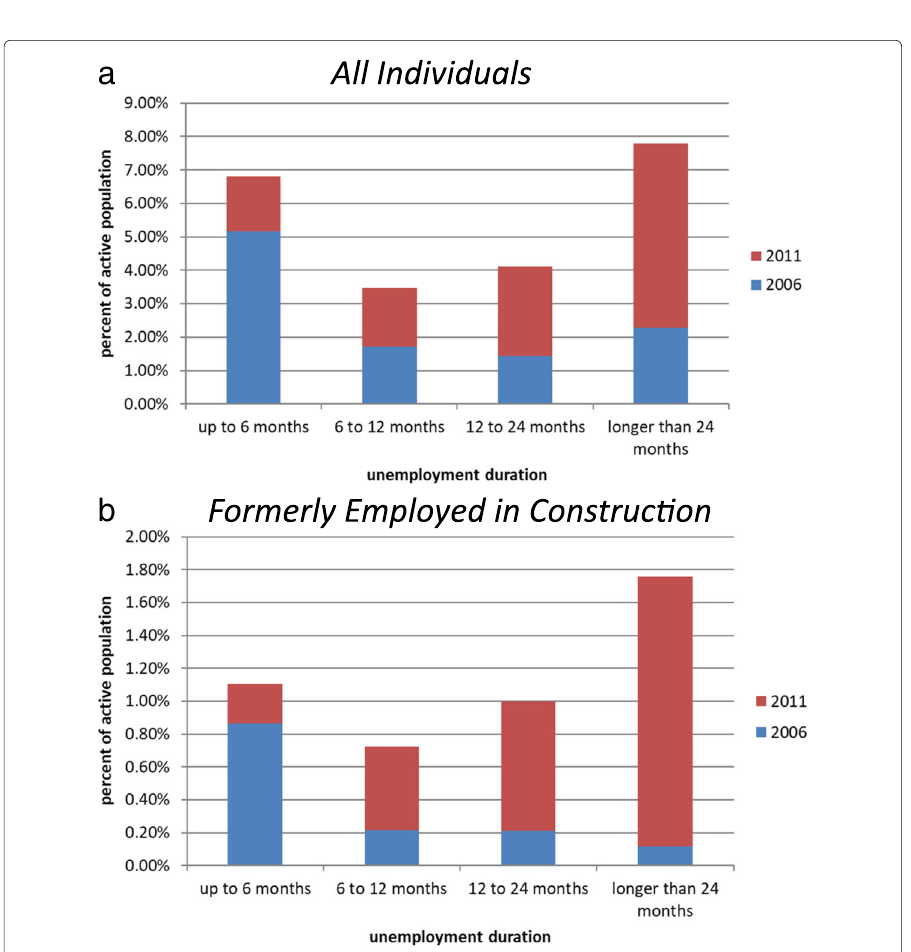
Fig. 4 a Increase in unemployment duration (all individuals). b Increase unemployment duration (formerly employed in construction). Note: Authors’ elaboration from Spanish National Health Survey